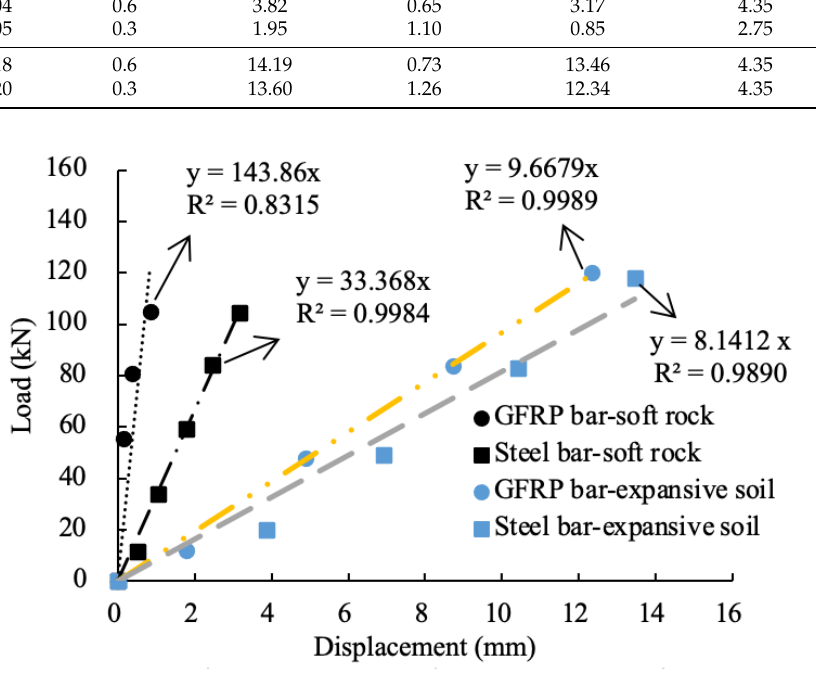
Figure 11. Bars displacement of anchorage section under loading.